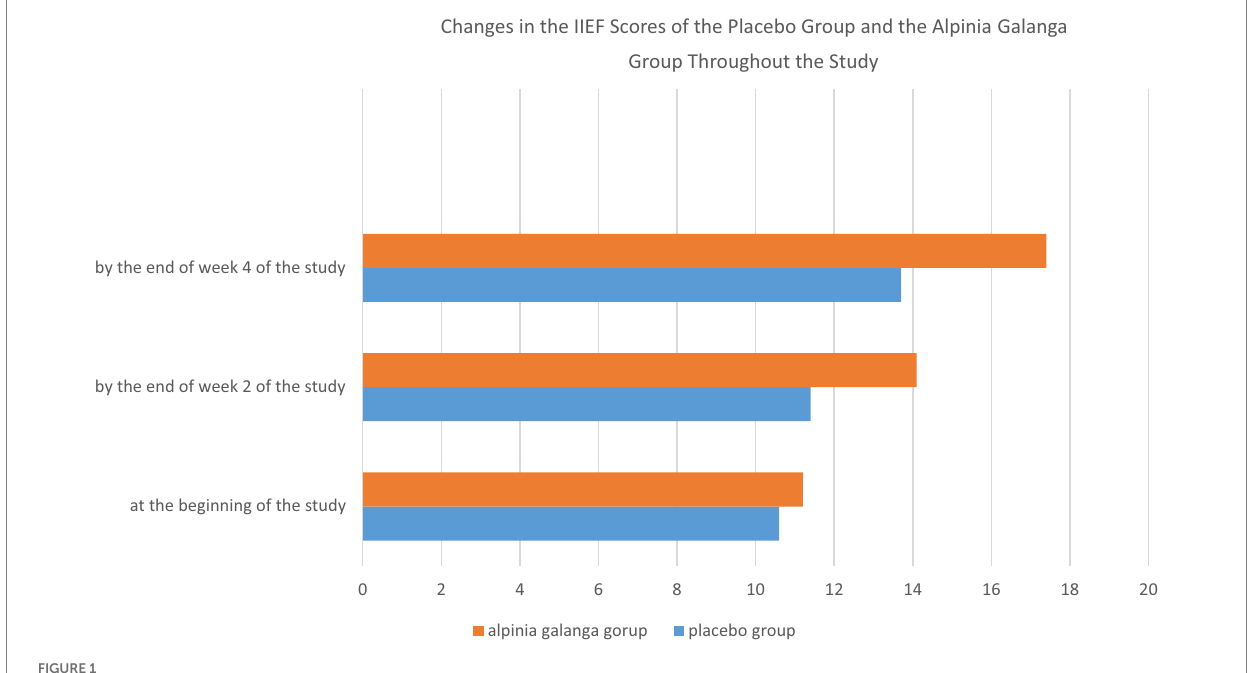
FIGURE 1 Changes in the IIEF scores of the placebo group and the Alpinia galanga group throughout the study.